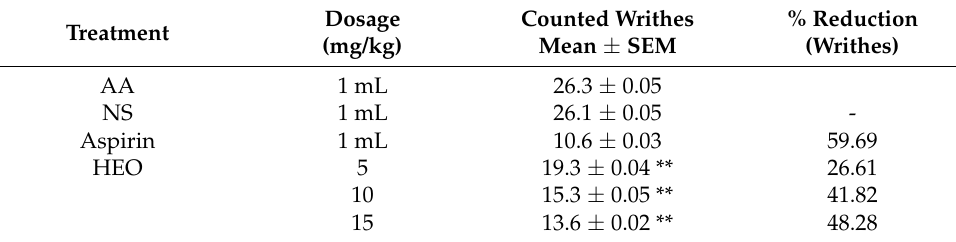
Table 6. Analgesic significance of S. edelbergii crude